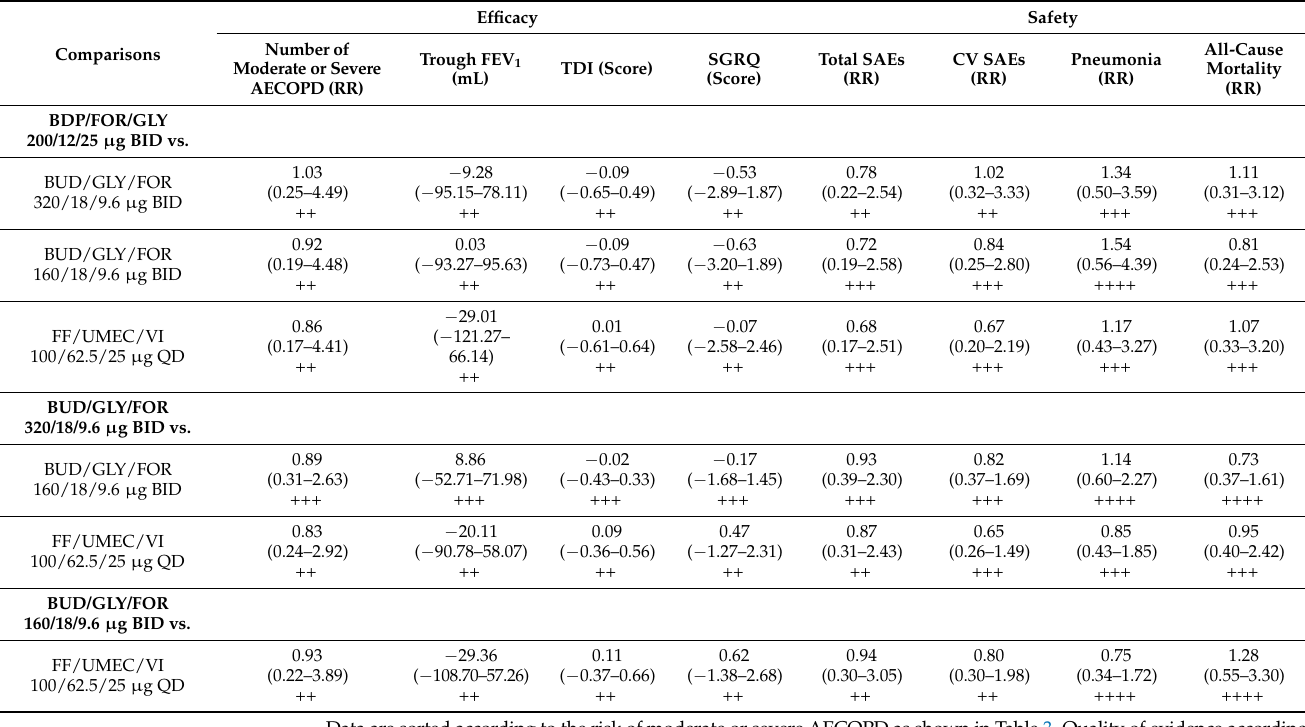
Table 2. Relative effects with 95% CrI and GRADE score resulting from the overall network meta- analysis; treatment comparisons are sorted in agreement with SUCRA.